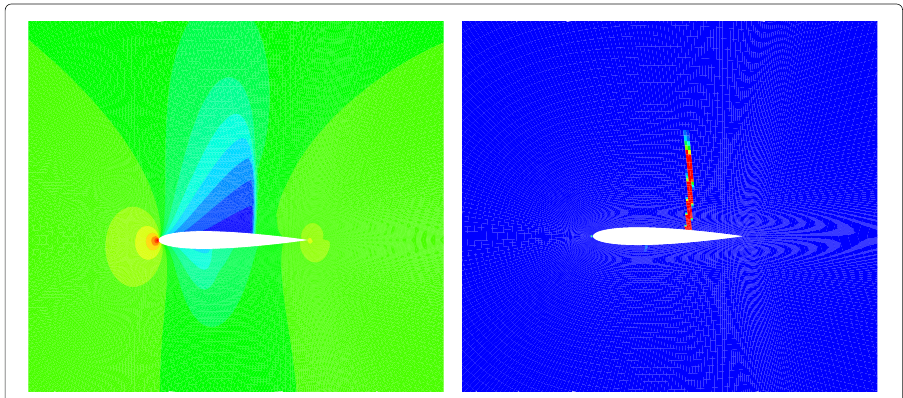
Fig. 7 Solution (density) and indicator in NACA0012 test case with Ma = 0.8, α = 1.25 ◦ in the 2D Euler equations on refined grids